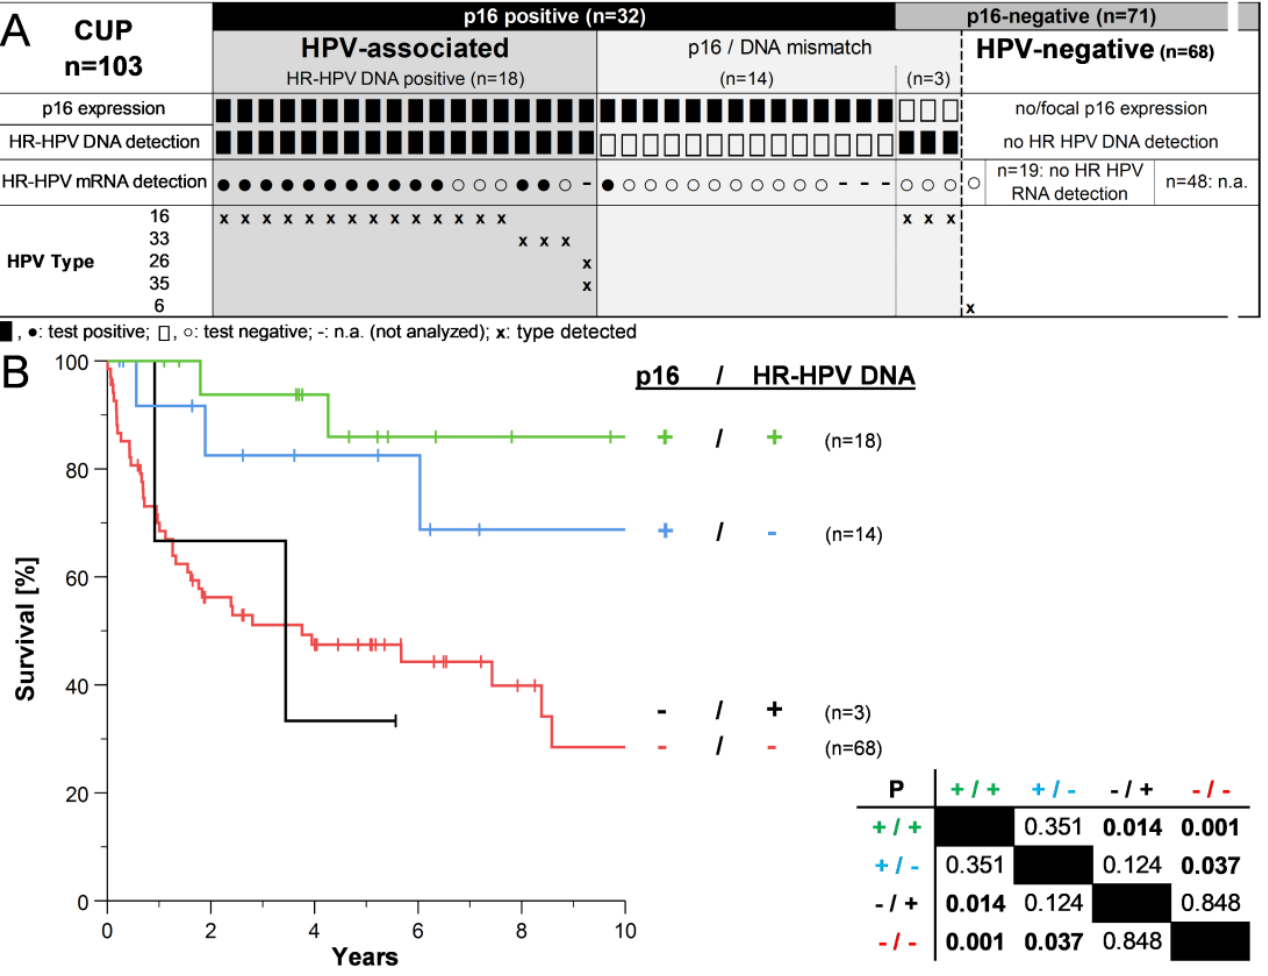
Figure 1. HPV status and overall survival (OS) of patients with cancers of unknown primary in the head and neck region (CUP HNSCC ). ( A ): HPV status of CUP HNSCC determined by detecting p16 INK4a (p16) expression and HR-HPV DNA and mRNA. ( B ): OS of patients with CUP HNSCC stratified by HPV status; censored cases indicated with vertical markers. p : p -value (log-rank test).